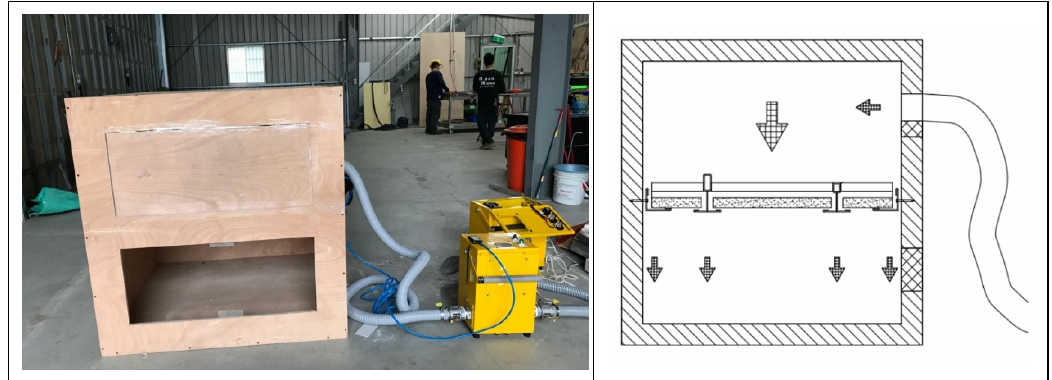
Figure 3. Installation of open-frame ceiling main frame and subframe in the test chamber.